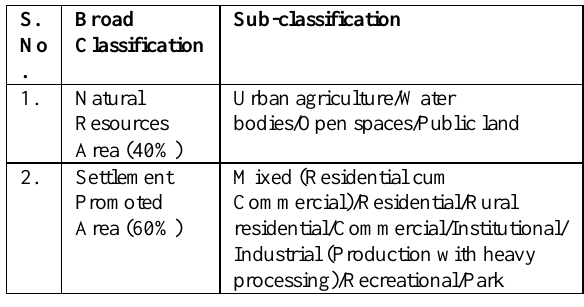
Table 2. Types of land use for City.